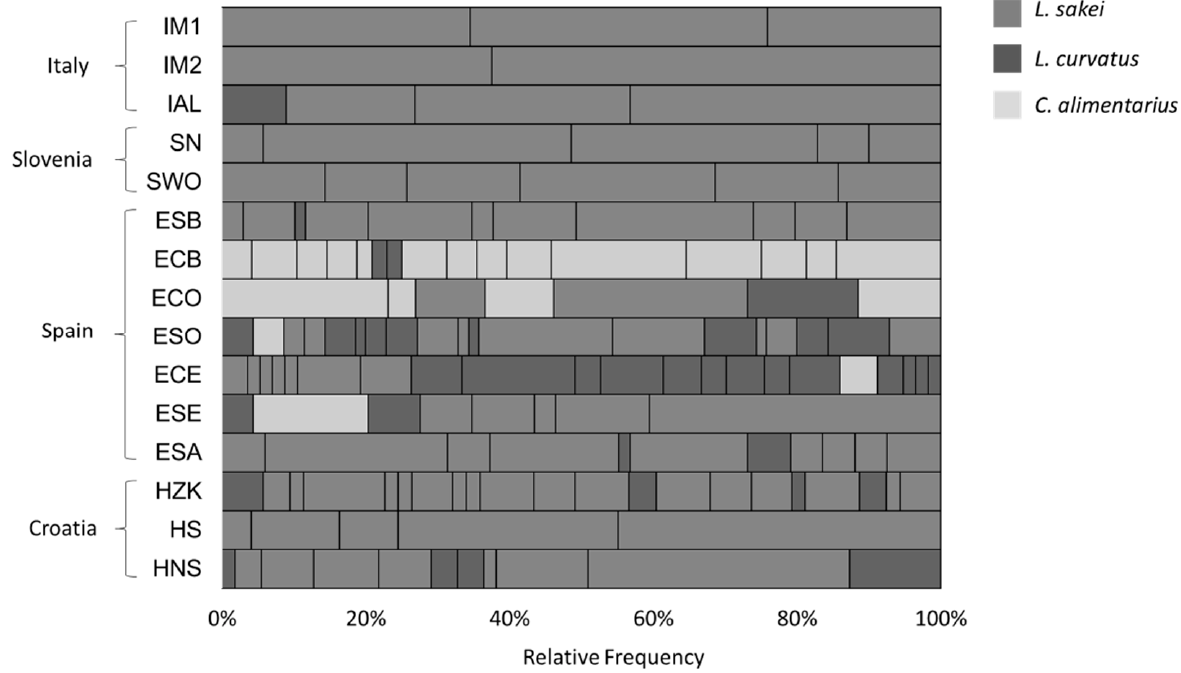
Figure 1. Relative frequency of LAB biotypes, identified as L. sakei , L. curvatus and C. alimentarius , found in each MC fermented sausages.